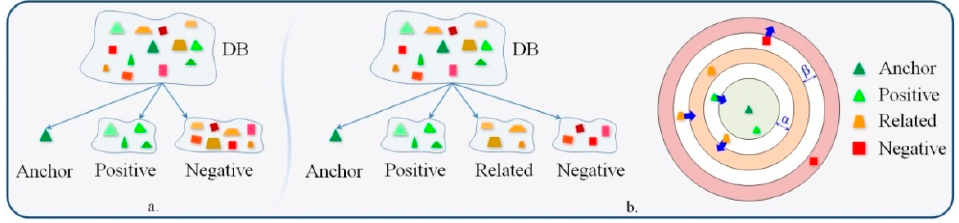
Figure 5. Difference between the triplet loss function and the emotion constraint. ( a ) The triplet loss function, and ( b ). The proposed emotion metric.